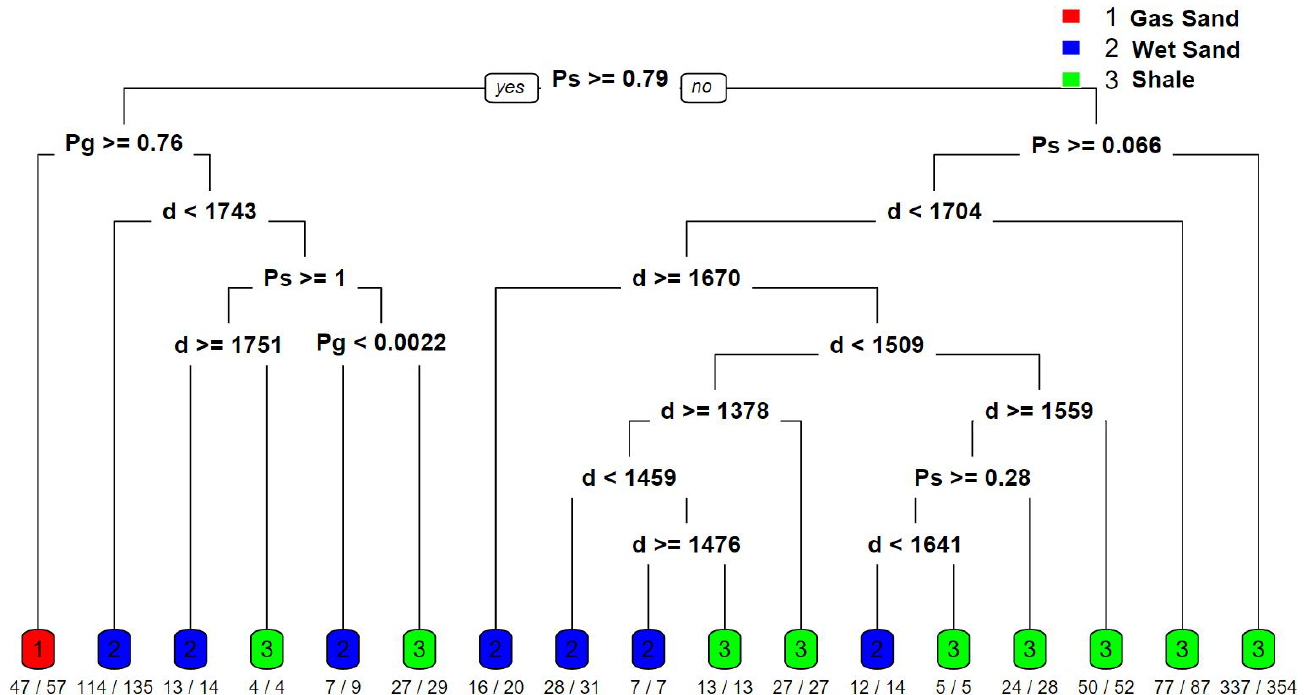
Figure 27. The graphical representation of the decision tree model, which classifies the training data of the well ( × 1) into gas sand in red, wet sand in blue, and shale in green. The input variables are the gas probability (Pg), sand probability (Ps), and depth